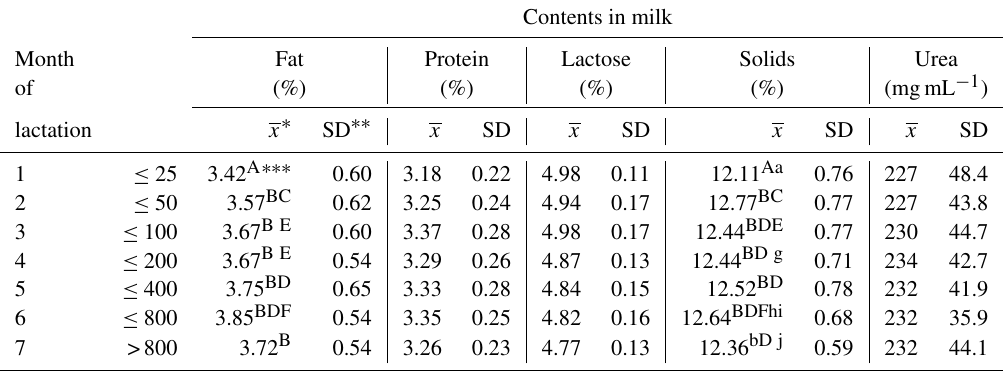
Table 5. Chemical composition of milk depending on SCC class.